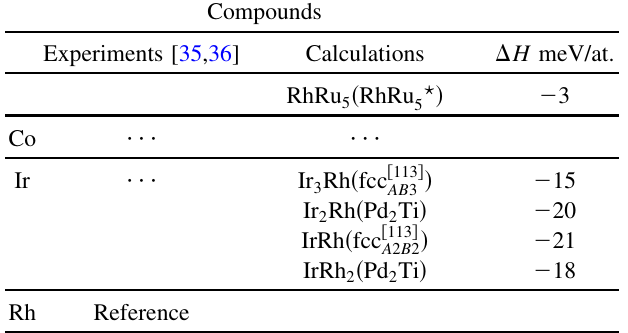
structure. All 2